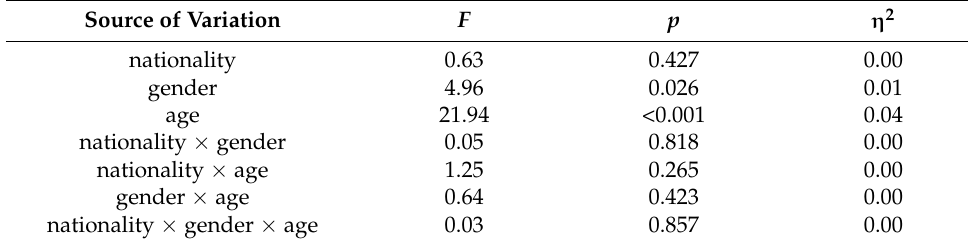
Table 3. Impact of demographic variables on BMI levels.